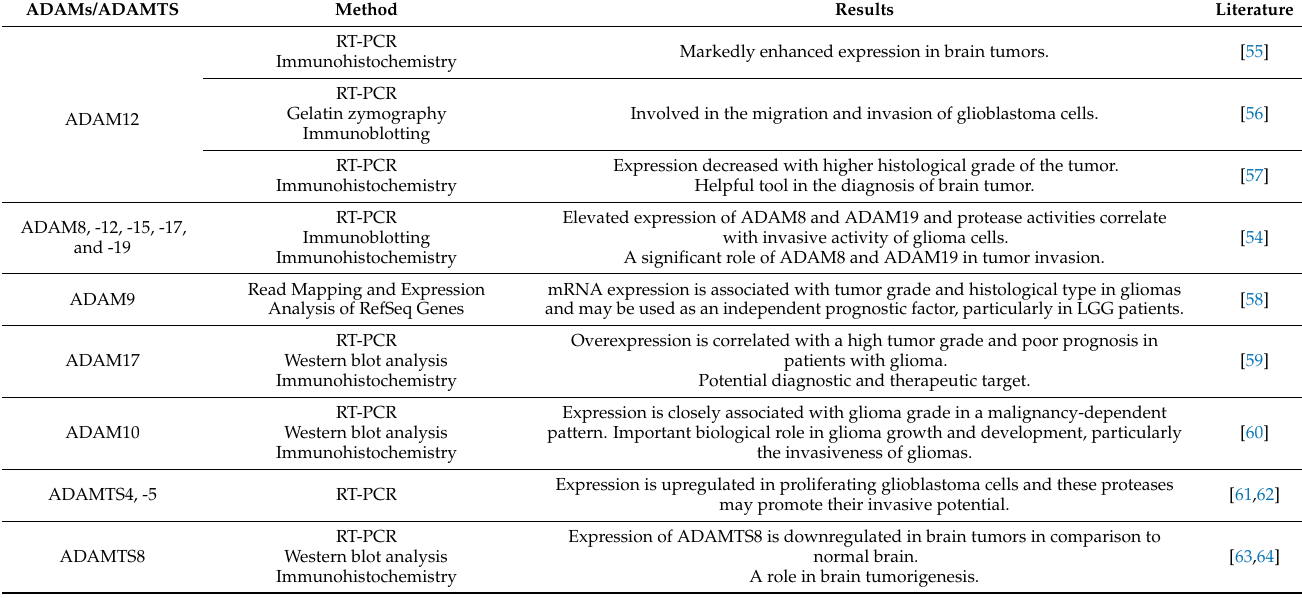
Table 1. The significance of selected ADAM family members as potential biomarkers of CNS